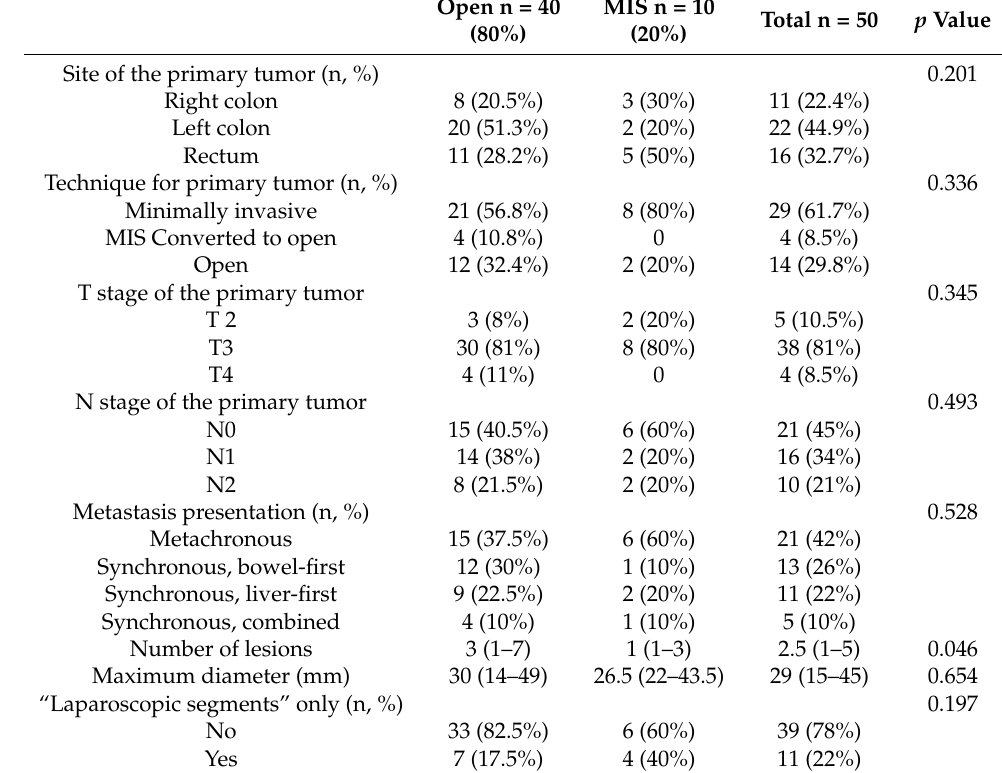
Table 2. Tumor characteristics.